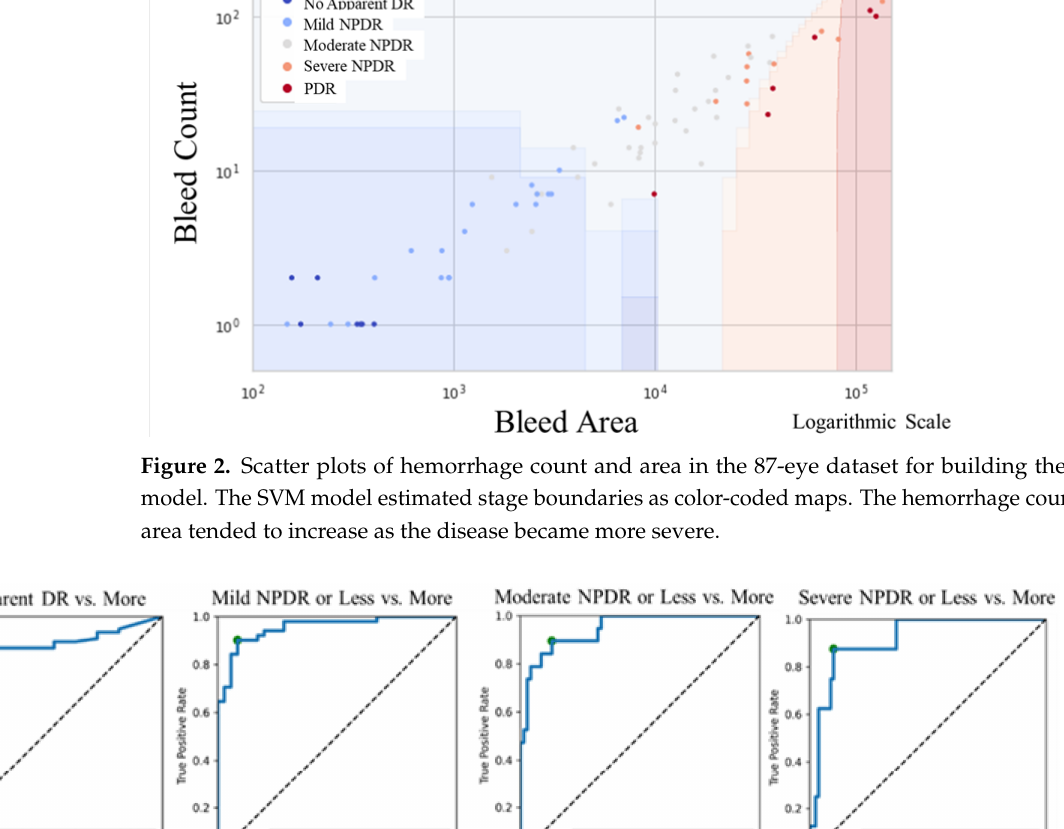
Figure 3. Receiver Operating Characteristic (ROC) curves of four threshold patterns in the SVM classification of the 87-eye dataset for building the SVM model.